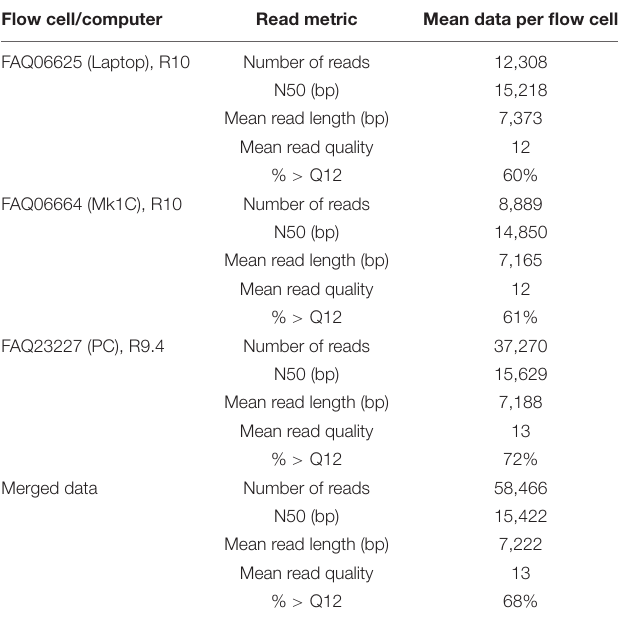
TABLE 5 | Sequence read metrics comparing the recovery yield, mean read quality (Q score), and N50 averages for n = 53 GNB isolates sequenced on three different flow cells, and